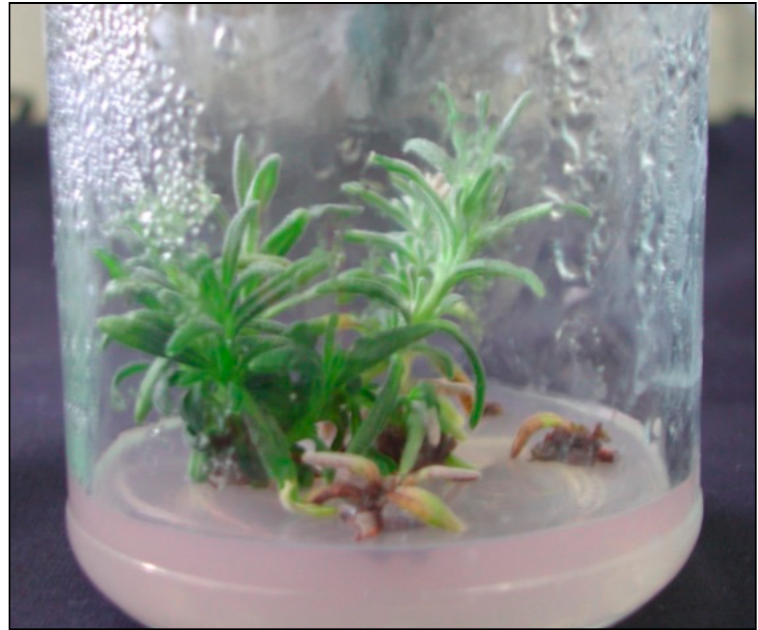
Figure 1. Plants of Lavandula angustifolia Mill. propagated on medium with 50 mg·dm − 3 AuNPs.